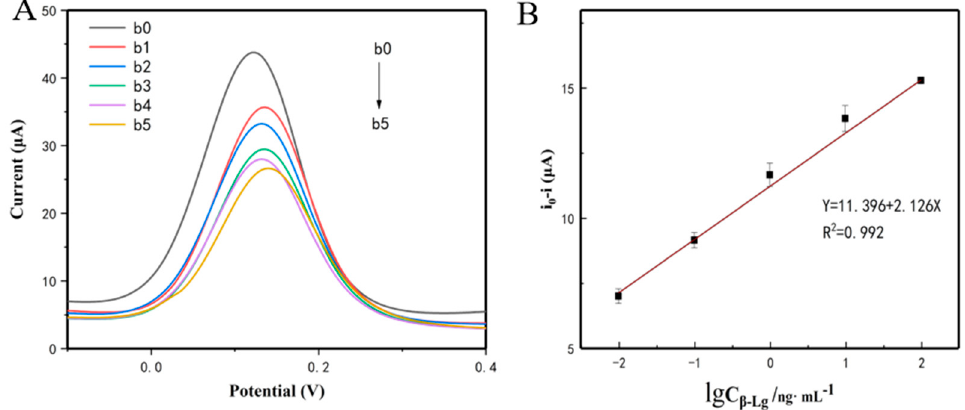
Figure 6. ( A ) Differential pulse voltammetry (DPV) responses of the proposed electrochemical sensors after incubation with different concentrations of β -Lg (b0 = 0 ng/mL, b1 = 0.01 ng/mL, b2 = 0.1 ng/mL, b3 = 1 ng/mL, b4 = 10 ng/mL, and b5 = 100 ng/mL). ( B ) The calibration curve of the developed electrochemical sensors for β -Lg.